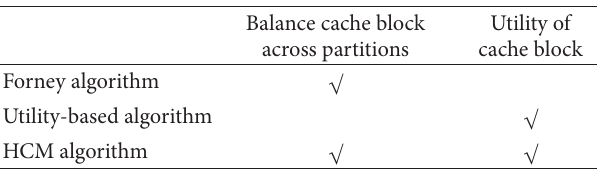
Table 1: Classification of cost-aware cache algorithms for heteroge- neous storage